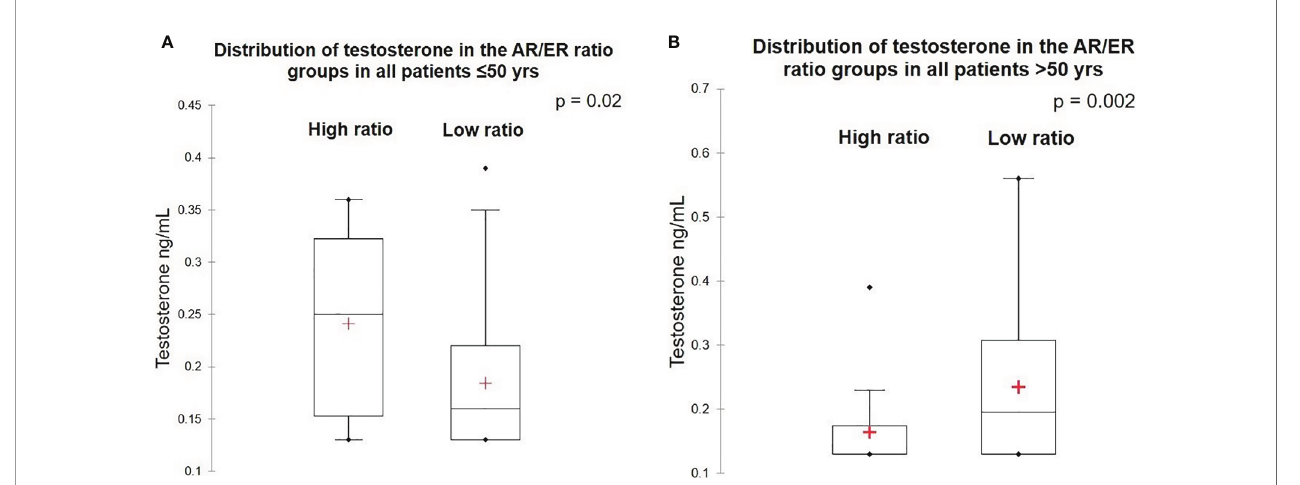
FIGURE 3 | Levels of testosterone in the high and low AR/ER ratio groups. (A) Distribution of testosterone in the patients ≤ 50 years. (B) Distribution of testosterone in the patients >50